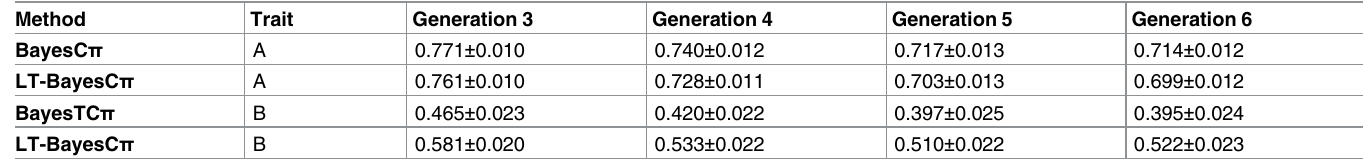
Table 1. Accuracies of GEBVs (mean ± s.e. from 20 replicates)obtained from three methods in generations 3–6 in the standard scenario.